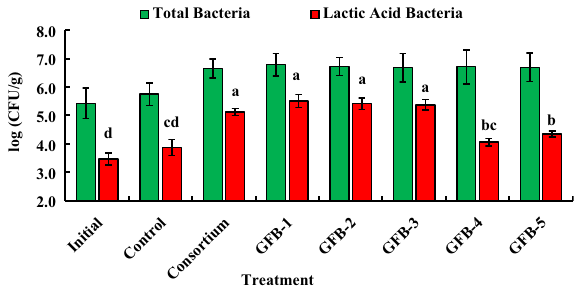
Figure 13. Assessment of consortium effects of five probiotic bacterial strains and individual effect of five probiotic bacterial strains viz . GFB-1, GFB-2, GFB-3, GFB-4 and GFB-5 isolated from the gut of B. gonionotus on the culturable autochthonous bacteria and autochthonous lactic acid bacteria levels (log CFU/g intestine) of the host. One way ANOVA was performed for analyzing the data of three replicated experiment and data in column varies significantly in LSD at P < 0.05 (Statistix 10). Different letter bars indicate significant variations in the culturable autochthonous bacteria and autochthonous lactic acid bacteria levels of the host fishes in different groups by the isolates at P < 0.05 (Statistix 10). Error bar = ± SD; n = 9.